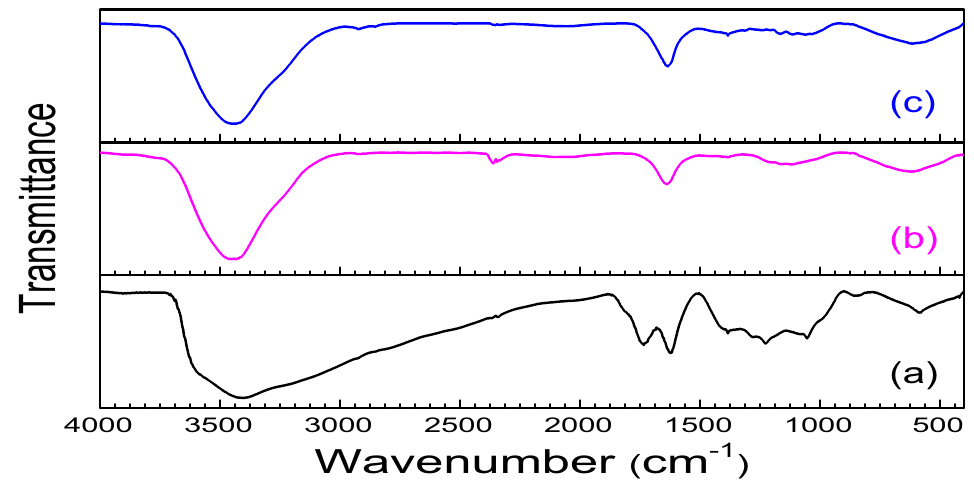
Figure 3. FT-IR spectra of ( a ) GO ( b ) after 2nd run and ( c ) after 5th run.